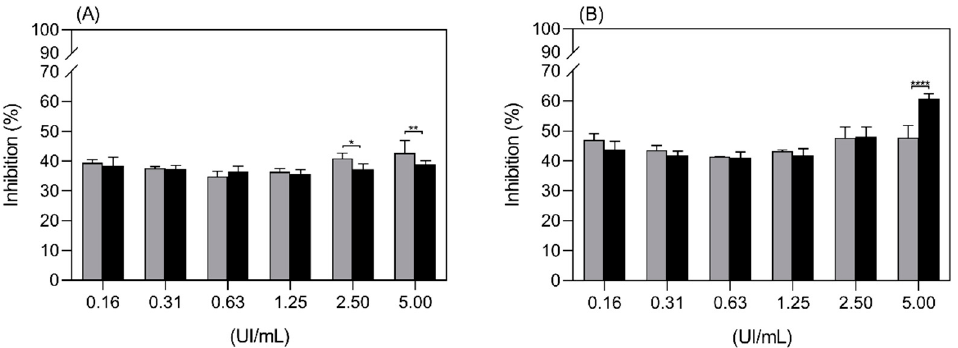
Figure 9. Inhibition of proliferation of the Jurkat cell line by ASP-enzymosomes (black bars) and ASP (grey bars) at 48 h ( A ) and 72 h ( B ). Each point is the mean ± SD, from one representative experiment. * p -value < 0.5, ** p -value < 0.01 and **** p -value < 0.0001.